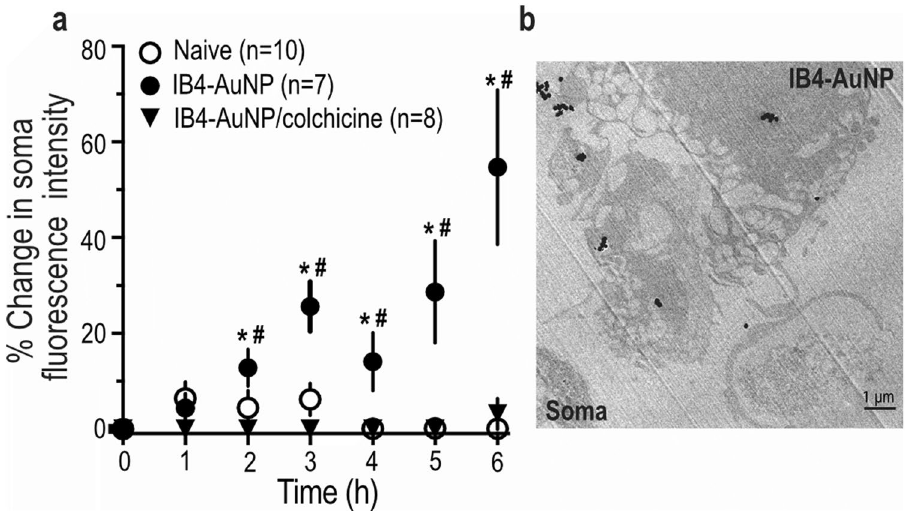
Figure 4. Axonal transport of IB4-AuNP to the cell body of sensory neurons. Graph indicating the time- dependent change in fluorescent intensity from cell bodies of dissociated rat DRG neurons within microfluidic devices, where AuNP conjugated with FITC tagged IB4 were treated in the axonal compartment (a). Data shown are mean ± S.D, * P < 0.05, IB4-AuNP vs Naïve, and # P < 0.05, IB4-AuNP vs IB4-AuNP with colchicine, one-way ANOVA with Sidak’s multiple comparison tests. Representative TEM image of DRG cells (b) collected from experiments in (a) , after 6 h, showing intracellular localization of gold